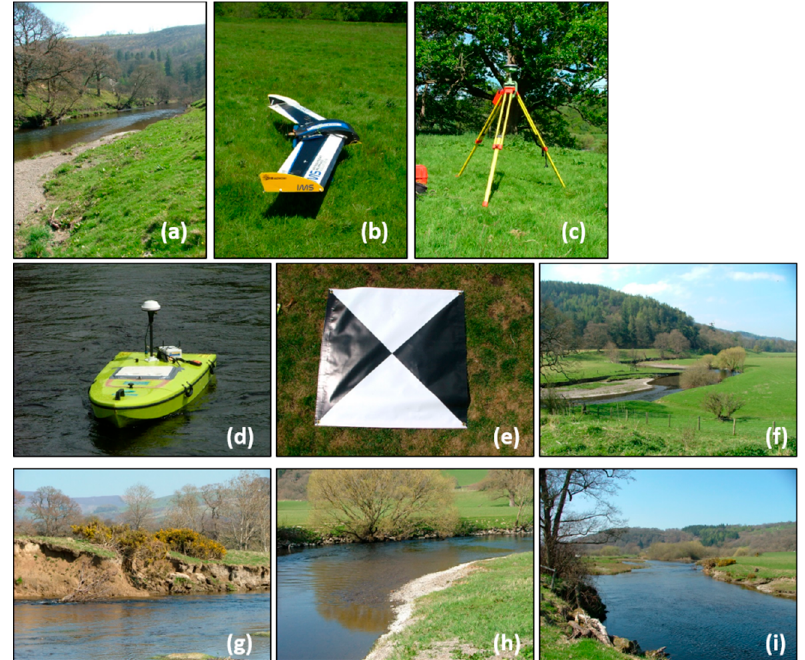
Figure 2. Detailed imagery showing the study site and the equipment used: ( a ) view of a side bar;